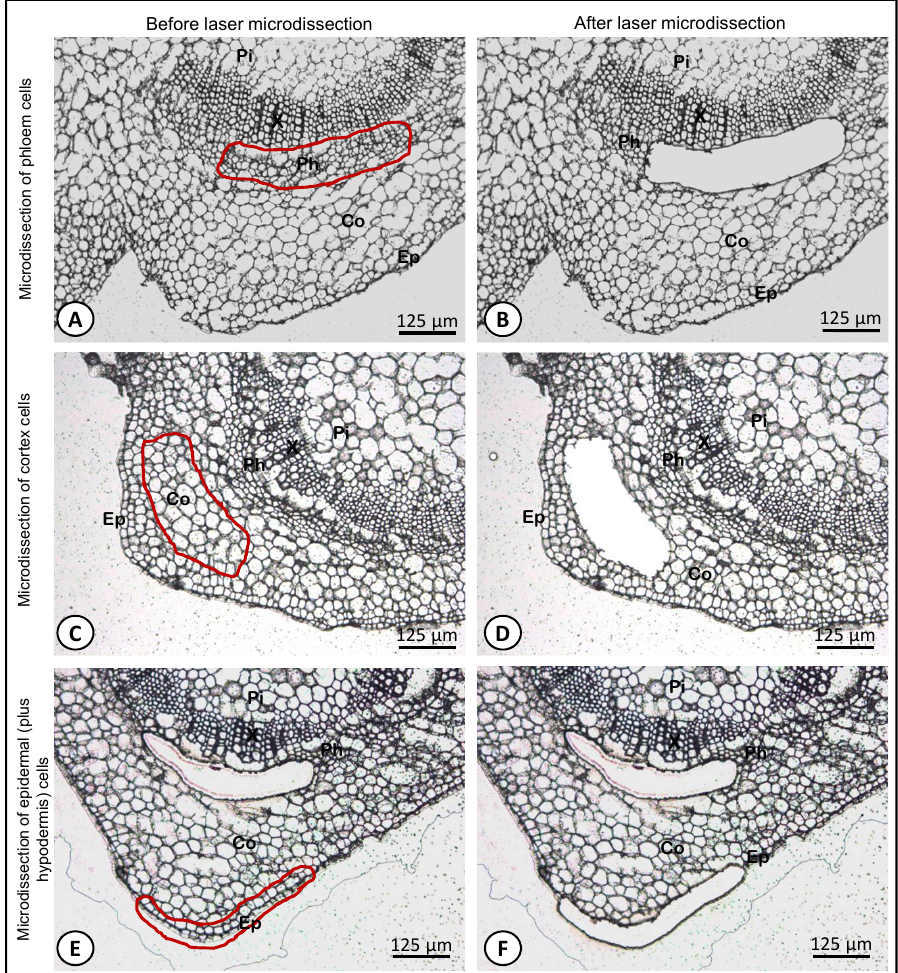
Figure 2. Cryosections of the stem nodal segments of olive microcuttings at the site of adventitious root formation before ( A , C , E ) and after ( B , D , F ) laser microdissection of cells from the phloem ( A , B ), cortex ( C , D ), and epidermis (plus hypodermis) ( E , F ) tissues. Pi, pith; Co, cortex; Ep, epidermis; Ph, phloem; X,